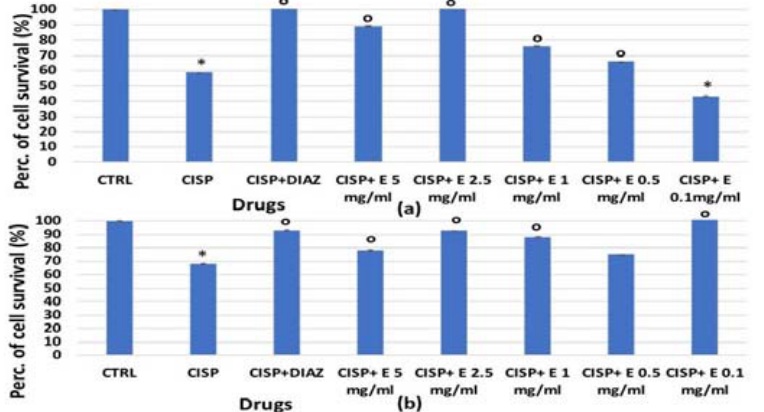
Figure 7. Percentage of cell growth values for the HEK293 cell line co-incubated with cisplatin 1 × 10 − 4 M (CISP) after ( a ) 48 and ( b ) 72 h of incubation time, and diazoxide 250 × 10 − 6 M (DIAZ) or various extract (E) concentrations in the crystal violet assay. The reported values represent an average of at least six replicates. One-way analysis of variance with ANOVA was performed to determine the significance of the data vs. controls * (CTRL) or cytotoxic ◦ compounds with a value of p < 0.05.